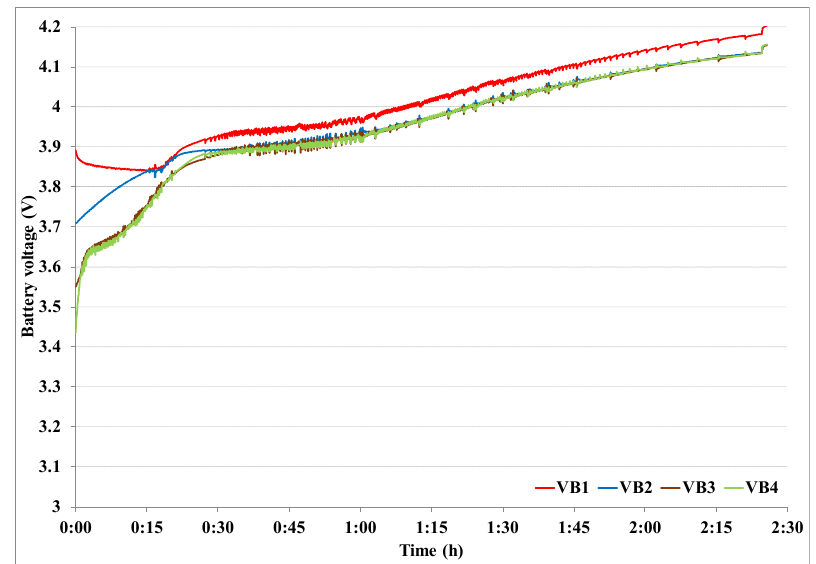
Figure 10. The balancing curves of battery voltage while charging.